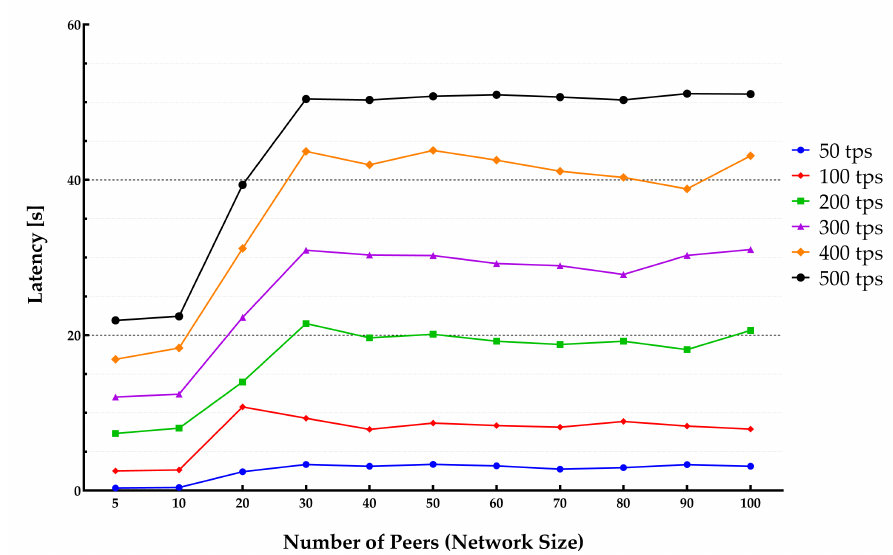
Figure 14. Impact of network size on transaction